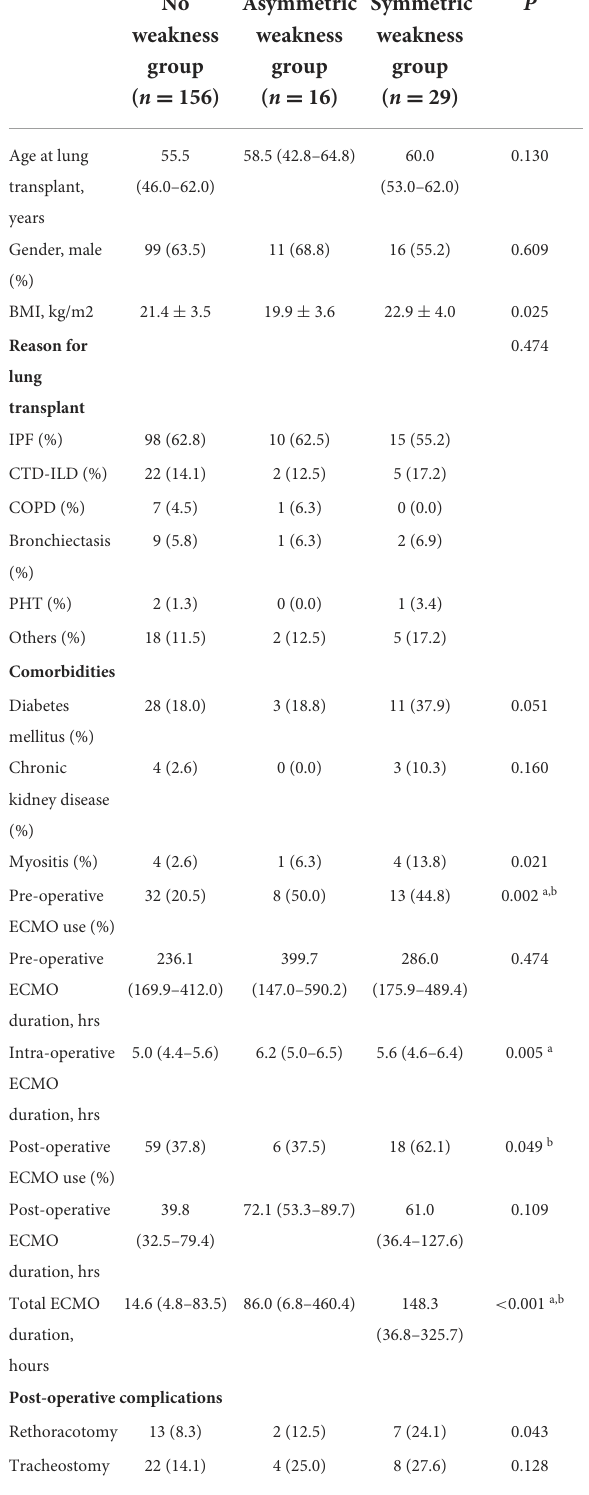
TABLE 1 Comparison of baseline clinical characteristics of lung transplantation recipients based on the presence and the pattern of postoperative leg weakness.